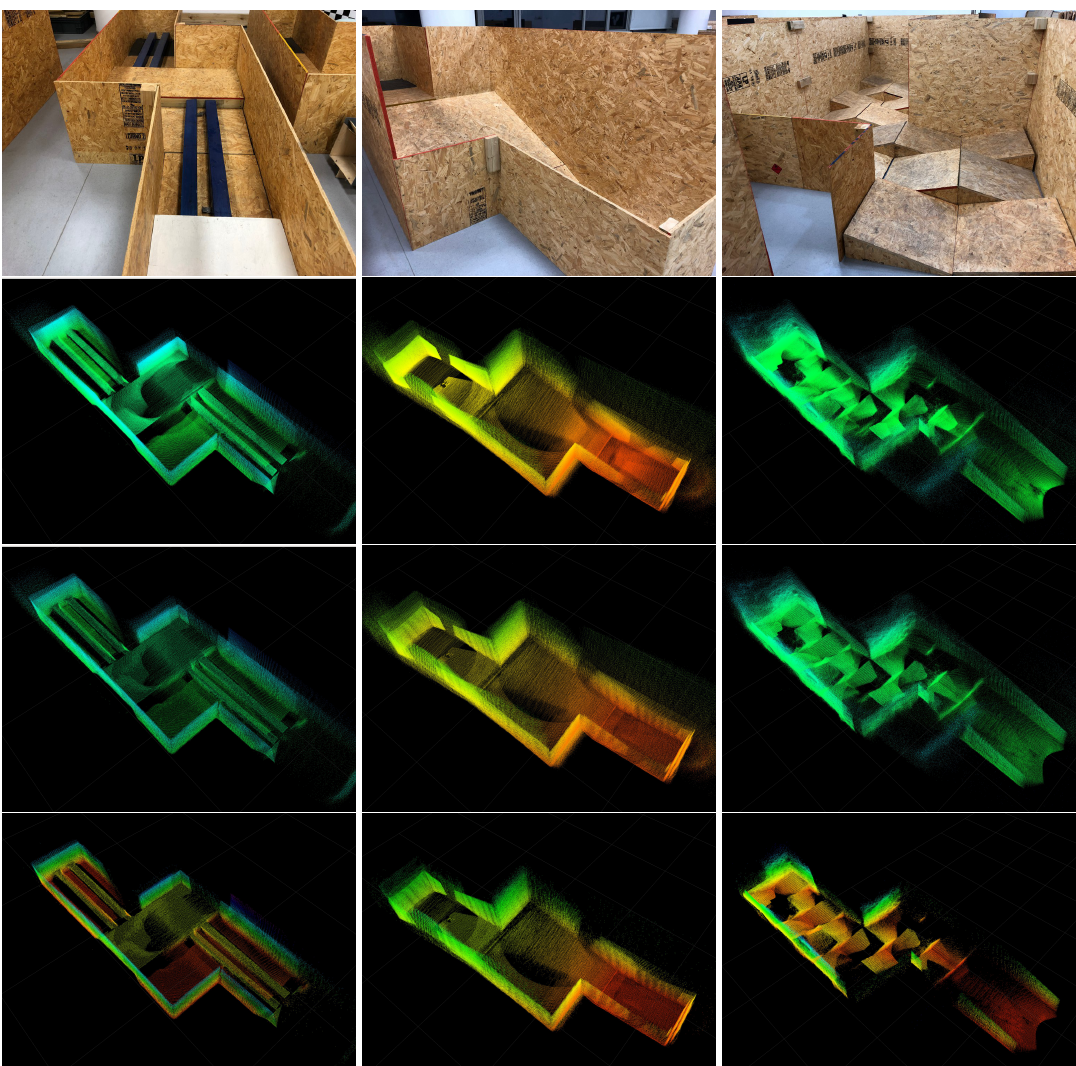
Figure 20. Mapping results in ASTM Standard Test